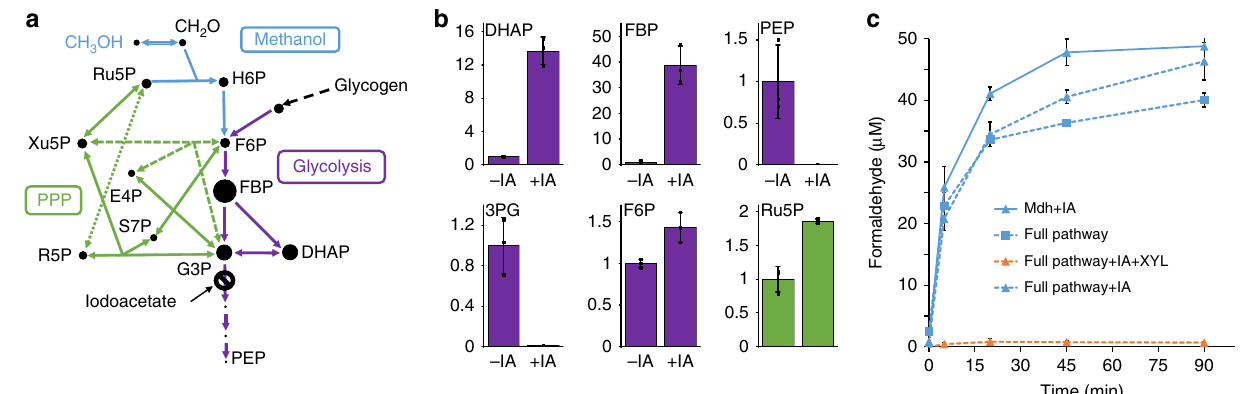
Fig. 3 Chemical inhibition of glycolysis with iodoacetate is insuf fi cient to improve formaldehyde assimilation. a Metabolic pathways in methanol metabolism, additionally depicting chemical inhibition of glyceraldehyde 3-phosphate dehydrogenase (GAPDH) by the addition of 1 mM iodoacetate (IA). Dot sizes indicate relative pool sizes after IA addition compared to untreated cells. b Relative internal concentrations of various metabolites with or without IA treatment, quanti fi ed by LC-MS/MS. Metabolites immediately upstream of GAPDH (DHAP and FBP) increased dramatically, while metabolites downstream of the blockage (e.g., PEP and 3PG) became virtually undetectable. c Formaldehyde levels after addition of 250mM methanol to starved cells of E. coli MG1655(DE3) Δ frmA . Solid lines denote cells expressing only Mdh, whereas dashed lines indicate cells expressing the full pathway (Mdh, Hps, and Phi). Triangles indicate cells treated with IA. Blue lines symbolize cells supplemented with no additional substrate beyond methanol, whereas orange lines represent cells supplemented with 6 g L − 1 xylose (XYL). Error bars represent s.d. of n = 3 biological replicates (three individual